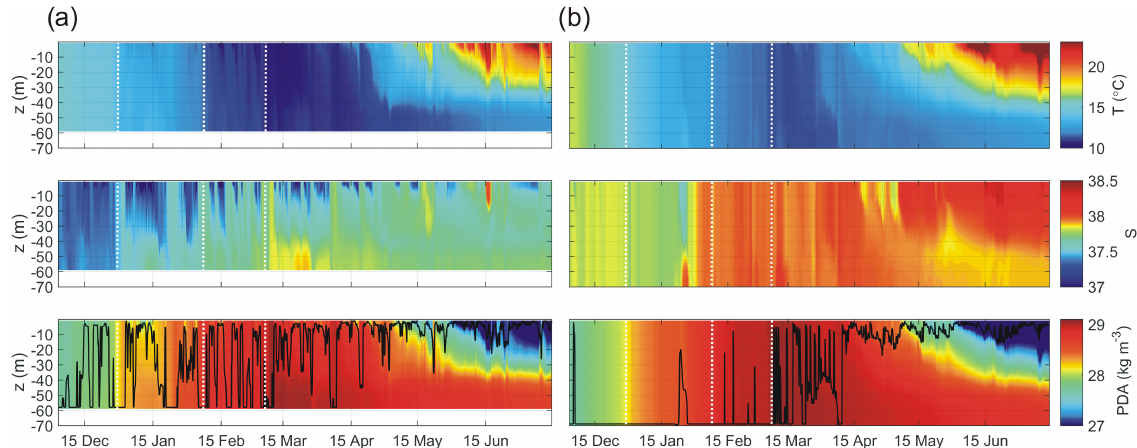
Figure 10. Hovmöller plot of modelled temperature, salinity and PDA values at grid points (a) G1 and (b) G2. Vertical dashed lines indicate three severe bora episodes discussed in Sect. 3, while the thick black line in the PDA plot shows mixed-layer depth.